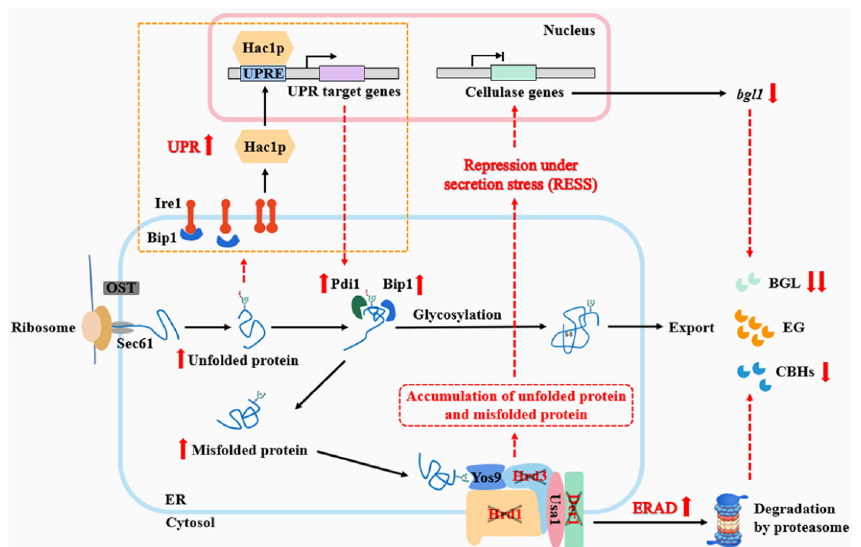
Figure 7. The mechanism diagram of cellulase secretion changes caused by the deletion of critical single ERAD components under high cellulase secretion conditions in T. reesei . When the newly synthesized cellulase is translocated across the ER membrane co-translationally via the ribosome- sec61 translocation machinery, it undergoes a series of protein folding and post-translational mod- ifications, such as molecular chaperone binding, disulfide bond formation and glycosylation, etc. Properly folded cellulase exits the ER, while unfolded or misfolded cellulase is recognized by Yos9 and directed to the ERAD pathway for degradation, where it is dislocated from the ER mediated by the Hrd1 ubiquitin ligase complex (Hrd1, Hrd3, Der1) and degraded by the cytosolic ubiquitin– proteasome system. Furthermore, when the baroreceptor Ire1 on the ER membrane senses a large number of unfolded and misfolded proteins, the UPR pathway, including Bip dissociation, Ire1 di- mer phosphorylation, Hac1 translation and binding to the UPRE region, is initiated and upregulates molecular chaperones and folding enzymes expression, such as Bip1 and Pdi1. Under the ER pres- sure caused by the single-component deletion of the Hrd1 complex (Hrd1/Hrd3/Der1), unfolded and misfolded cellulases accumulate, which strongly activates the UPR, ERAD and RESS pathways. ERAD single-component deletion strengthens other components to make up for its absence, possi- bly resulting in degradation of cellobiohydrolase and decreased secretion. At this time, the ER stress prompts the cell to activate the RESS pathway, which may significantly reduce the expression and secretion of β -glucosidase. Gray cross means that the ERAD component (Hrd1/Hrd3/Der1) has been knocked out. Red dotted line represents the impact caused by ERAD single-component deletion. Red up and down arrows respectively indicate the increase and decrease in elements after ERAD single-component deletion. Supplementary Materials: The following supporting information can be downloaded at: www.mdpi.com/xxx/s1. Table S1. Primers used in this study. Figure S1. Construction and verifica- tion of ERAD deletion strains Δ der1 , Δ hrd1 and Δ hrd3 . Figure S2. Radial extension rates of the ERAD- deficient mutants on different carbon sources. Figure S3. Cell wall stability of the ERAD-deficient mutants without ER pressure. Figure S4. Growth curve and ER pressure of the ERAD-deficient mu- tants under normal growth conditions. Author Contributions: C.Y. and Y.Z. conceived the work and drafted the manuscript. M.Y. and C.Y. performed the experiments. C.Y. analyzed the data. K.L., W.G., X.L., J.Z. and H.L. designed the work and revised the manuscript. All authors have read and agreed to the published version of the man- uscript. Funding: This work was supported by grants from the National Natural Science Foundation of China (No. 31970070), the grants from the National Key R&D Program of China (No. 2018YFA0900500; 2021YFC2101300) and the Youth Interdisciplinary Science and Innovative Re- search Groups of Shandong University (2020QNQT006). Institutional Review Board Statement: Not applicable.